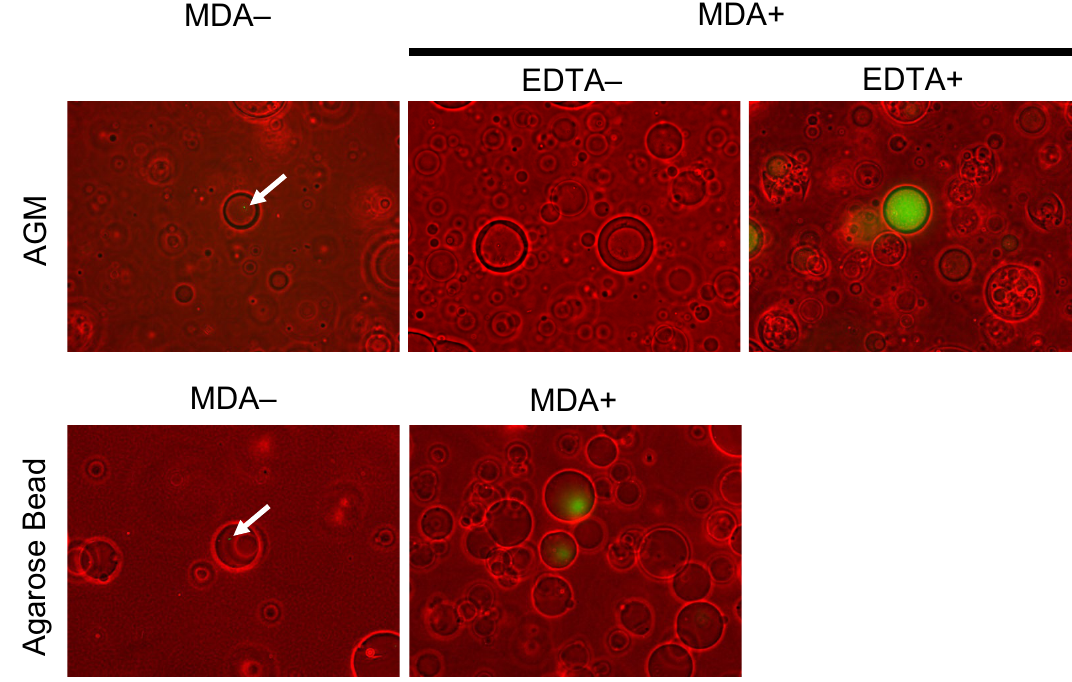
Figure 2. Yield enhancement of multiple displacement amplification (MDA) by alginate core solation. The effect of alginate core solation on the productivity of MDA within agarose gel microcapsules (AGMs) was evaluated. The genomic DNA of Escherichia coli encapsulated within AGMs was amplified by MDA with or without alginate solation using EDTA. The amplified DNA was detected with SYBR Green I. A phase contrast image (red) and epifluorescent image (green, SYBR Green I) are overlaid. MDA in agarose gel beads (without an alginate core), which was prepared using gelation of agarose droplets containing E. coli in oil emulsion, was also conducted as a control experiment. Arrows indicate E. coli cells stained with SYBR Green I. Bar = 100 with SYBR Green I were individually transferred to 0.2 mL PCR tubes with 29 µL of sterile water under an epi- fluorescence microscope equipped with a TransferMan NK2 micromanipulator (Eppendorf), which required approximately 5 min per AGM. The micromanipulator was used in this study due to its low initial cost. Several tens of the picked AGMs were sequenced as follows. Amplified DNA in the AGM was released into water by heating the tubes at 60 °C for 5 min and directly used for the preparation of sequencing libraries using the QIAseq FX DNA Library Kit (Qiagen). No second round of MDA was necessary to obtain libraries suitable for genome sequencing. Paired-end sequence reads were generated on an Illumina MiSeq platform with the Reagent Kit V3 (600 cycles), and a fixed number of read pairs were randomly chosen and assembled de novo into con- tigs using SPAdes 3.13.0 28 after standard quality filtering. Contigs > 1 kb were used for the subsequent analyses. Several factors describing the genome sequence quality, including completeness and contamination rate, were evaluated using CheckM 29 and QUAST 30 and compared between the SAGs obtained using MDA-in-AGM and FACS-MDA. The genome completeness and the total sequence length of E . coli SAGs obtained by MDA-in-AGM rapidly